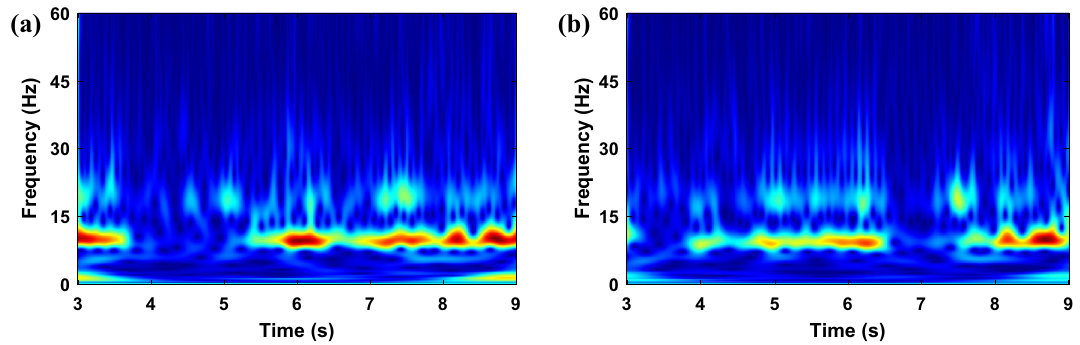
Figure 4. Absolute of Stockwell TFM corresponding to the left-hand MI signal from dataset II–III. ( a ) C3 channel, ( b ) C4 channel.